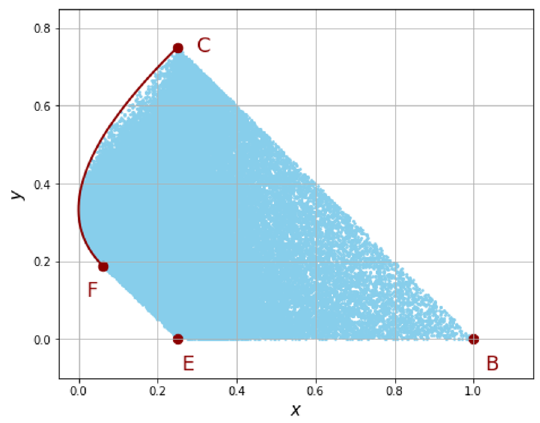
Figure 4 . The orbit space of the S 4 -symmetric 3HDM on the z = 0 plane. Shown are the corner points and the arc FC. The dots represent the numerical results of a random scan in the space of Higgs